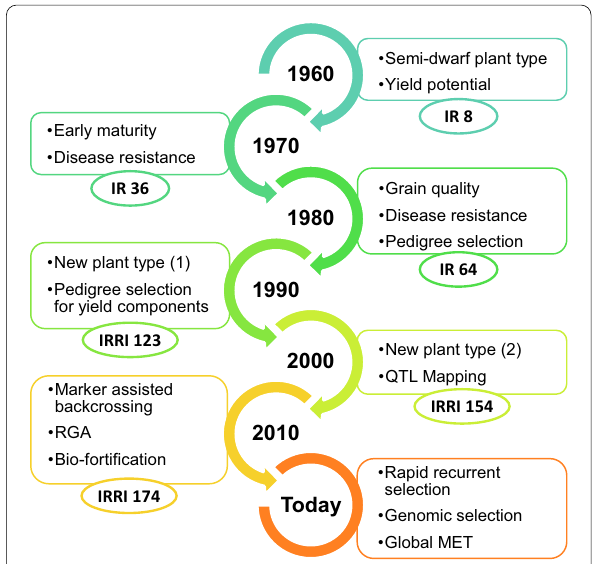
Fig. 1 Evolution of main techniques and breeding targets across decades for the irrigated breeding program at IRRI. Changes in breeding objectives in the decade are indicated in the